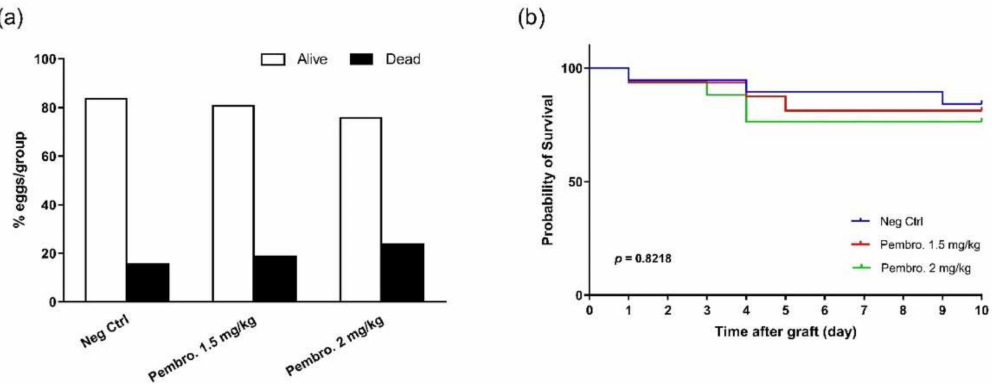
Figure 7. Survival of H460 Xenografted Embryos Following Pembrolizumab Treatments. ( a ) The final alive and dead ratios were recorded; ( b ) Kaplan–Meyer curve presents the survival evolution after in ovo H460 xenografting at EDD9.